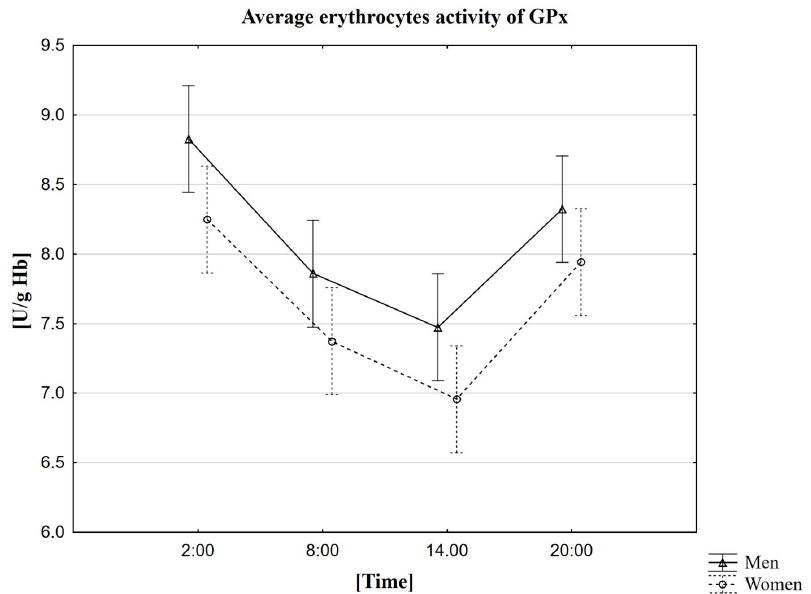
Table 5. Parameters describing glutathione peroxidase (GPx) activity in women and men, including the time of blood collection (U/g Hb).